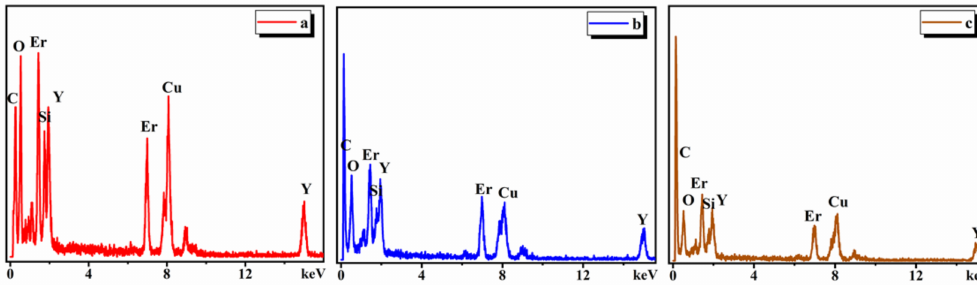
Figure 14. Di ff erent EDS analysis of the triple junction grain boundary: ( a ) completely crystallized, ( b ) partially crystallized, and ( c ) completely non-